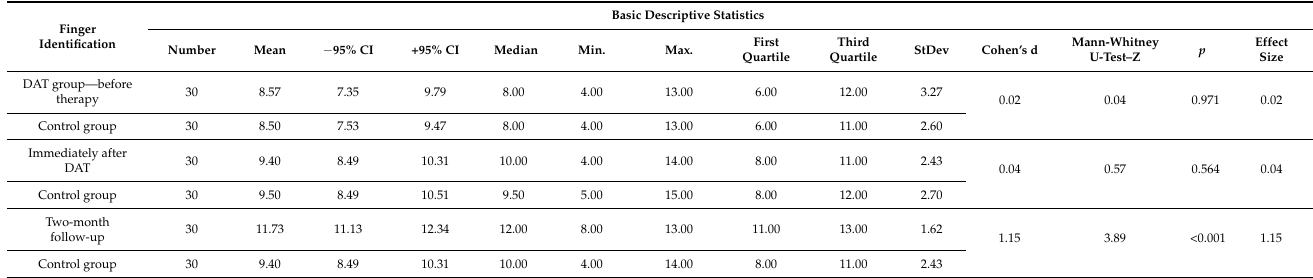
Table 6. Finger identification—comparison of the scores achieved by the DAT group and the